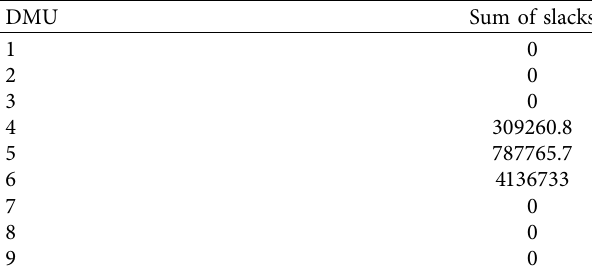
Table 4: Results of objective function from model equation (5) for DMUs.